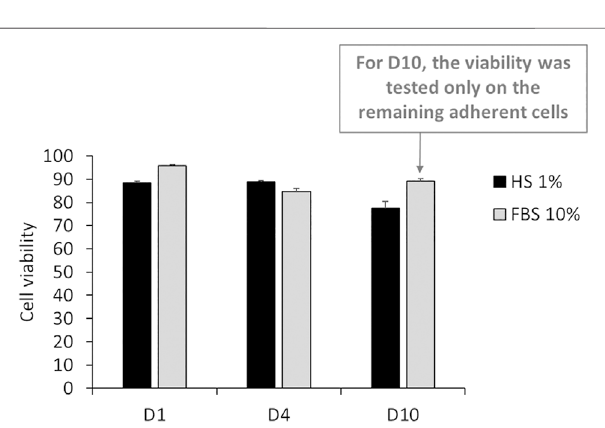
FIGURE 3 | Percentage of living cells after 24 h (D1), 4 days (D4) and 10 days(D10)ofcultureinDMEM+1%HorseSerum(1%HS). Blackbars;culture mediumsupplementedwithDMEM+1%HorseSerum(1%HS).Greybars;culture mediumsupplementedwithDMEM+10%FetalBovineSerum(FBS)(N (cid:1) 3).